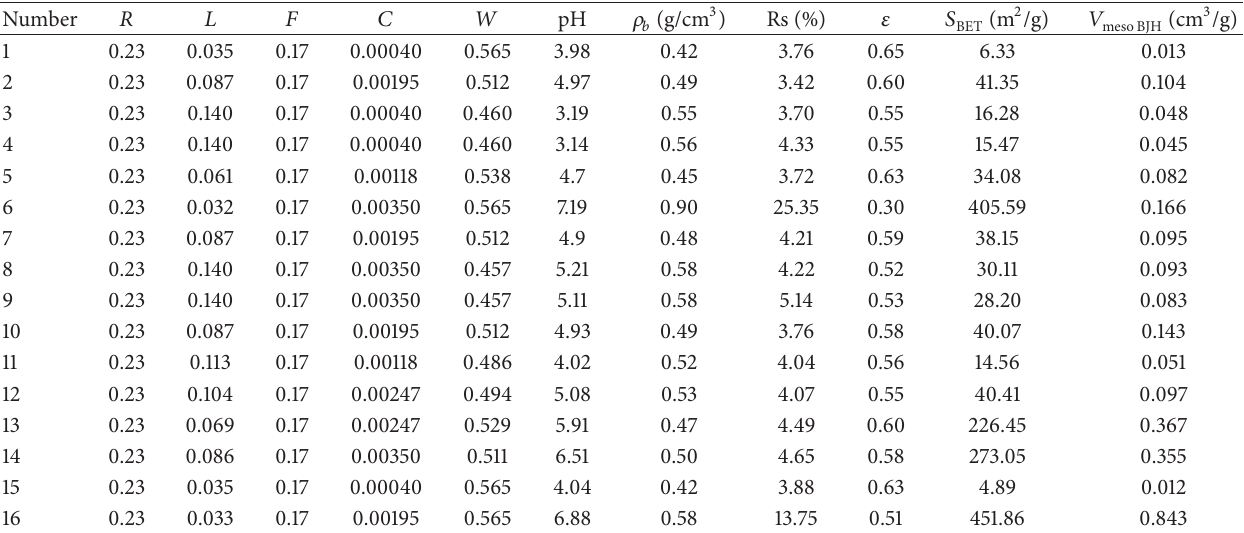
Table 5: Matrix and results for D-Optimal design (mass fraction).